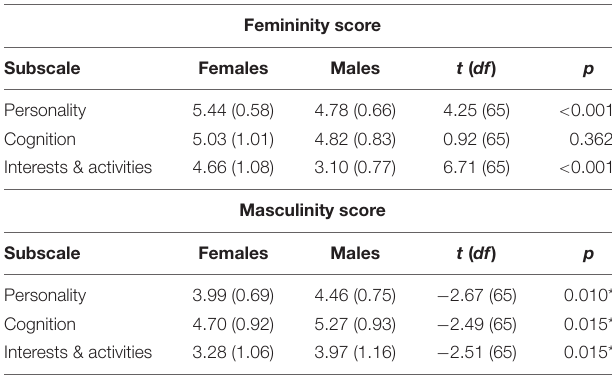
TABLE 2 | Mean femininity and masculinity scores (and standard deviations) for female and male participants for the Gender-Related Attributes Survey (GERAS)